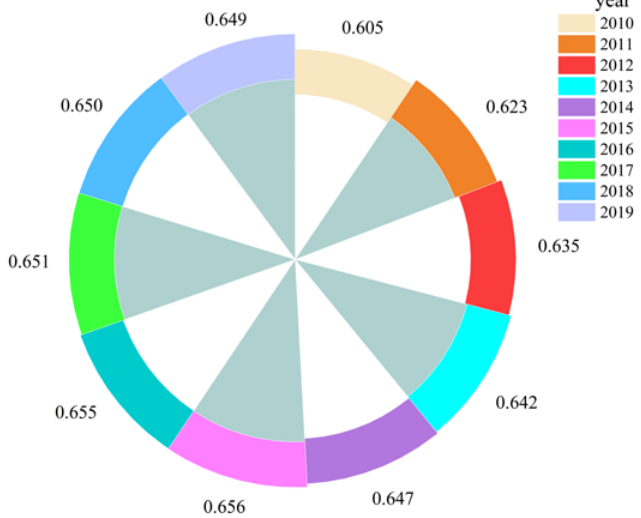
Figure 9. The SED of HQD from 2010 to 2019.